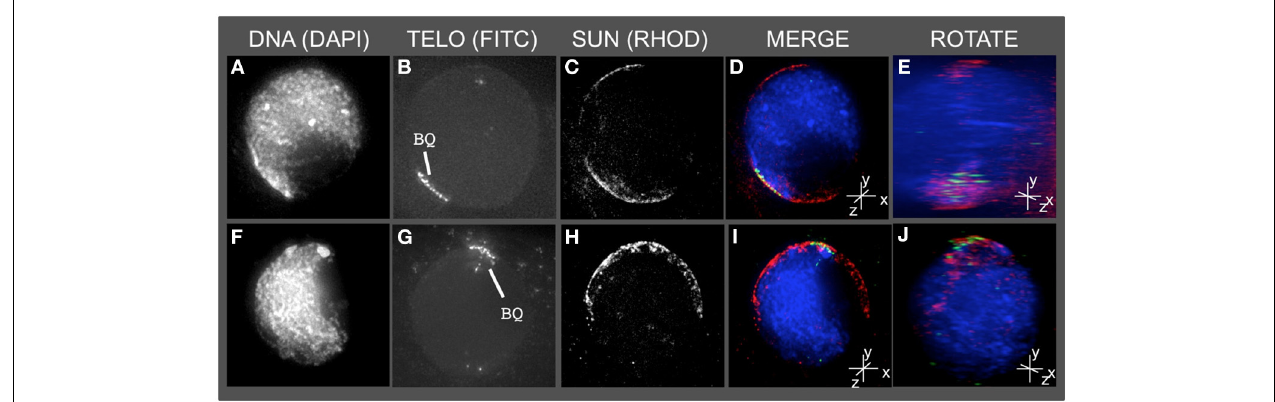
FIGURE 3 | The telomere cluster bouquet colocalizes with the SUN belt at zygotene. Protein immunolocalization followed by 3D telomere FISH was used to analyze the location of meiotic telomeres relative to the distribution of SUN proteins in meiotic anthers harvested from maize inbred line A344 + / + . 2D projections of the entire 3D data sets are presented for two